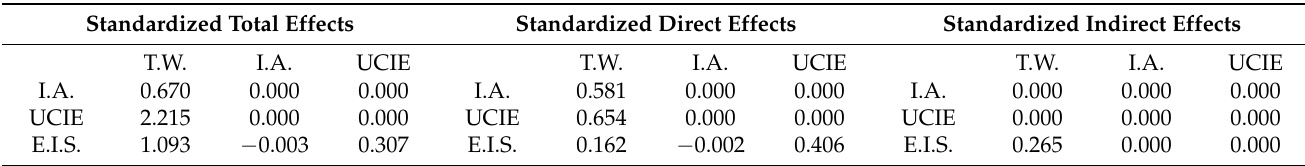
Table 5. The standardized effects registered between the variables of the structural equations modeling. Standardized Total Effects Standardized Direct